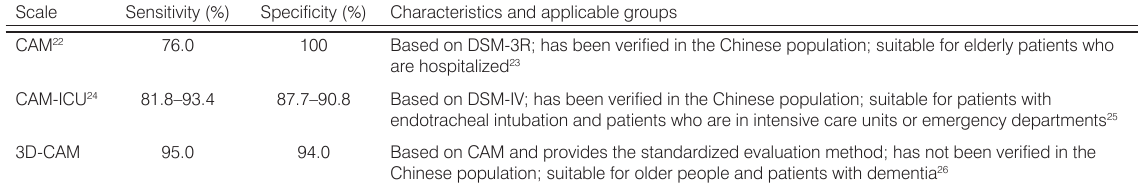
Table 3. Commonly used delirium assessment